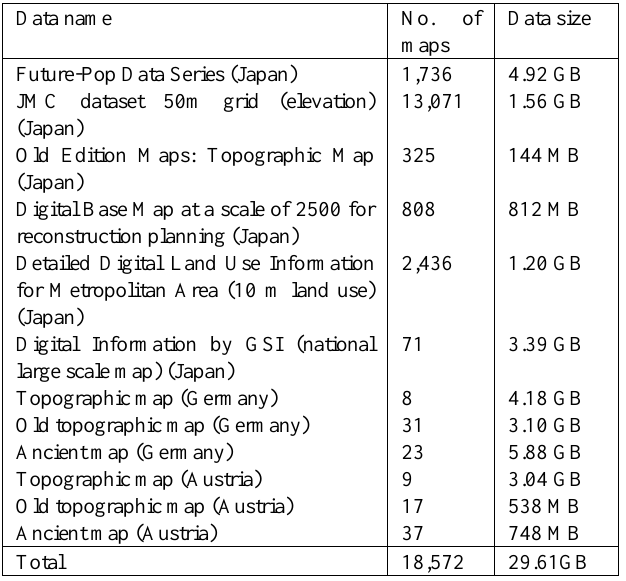
Table 1. Summary of dataset